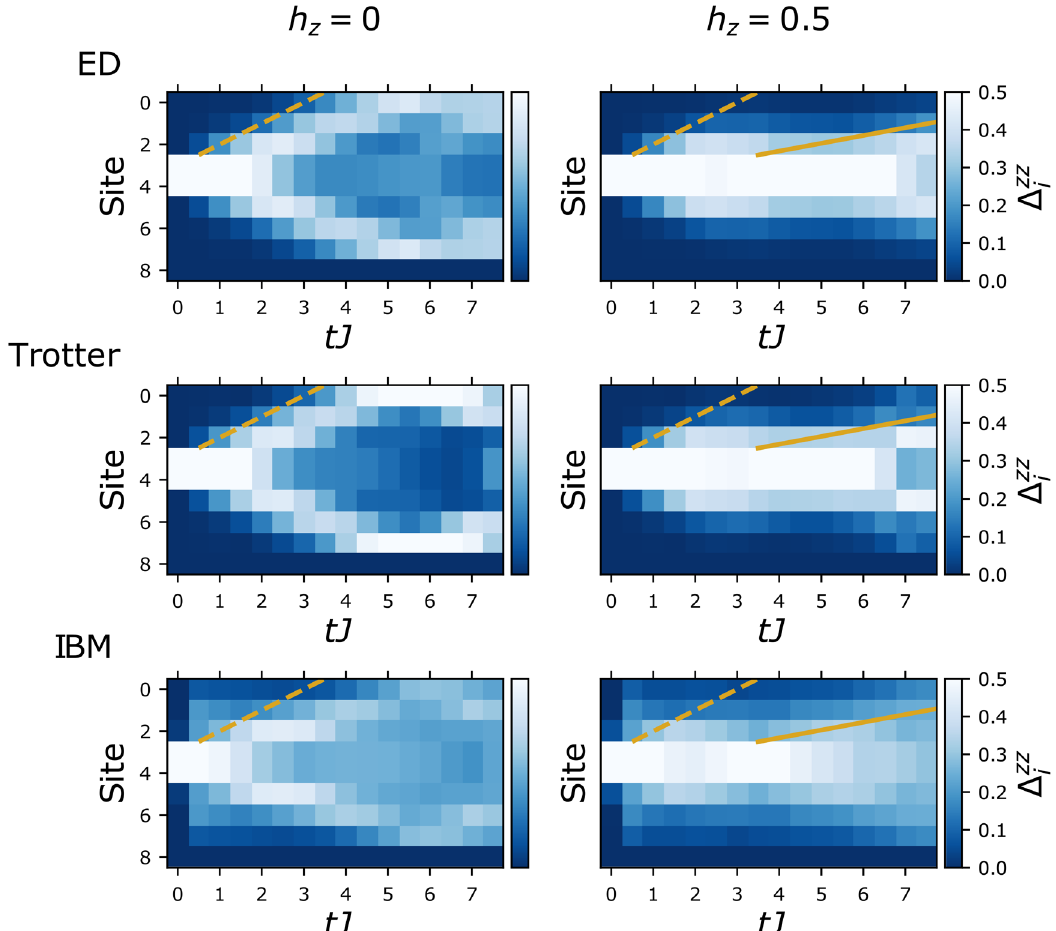
zz i after a global quantum quench to L − 1 , 1 � . In all presented data h x = 0.5 2